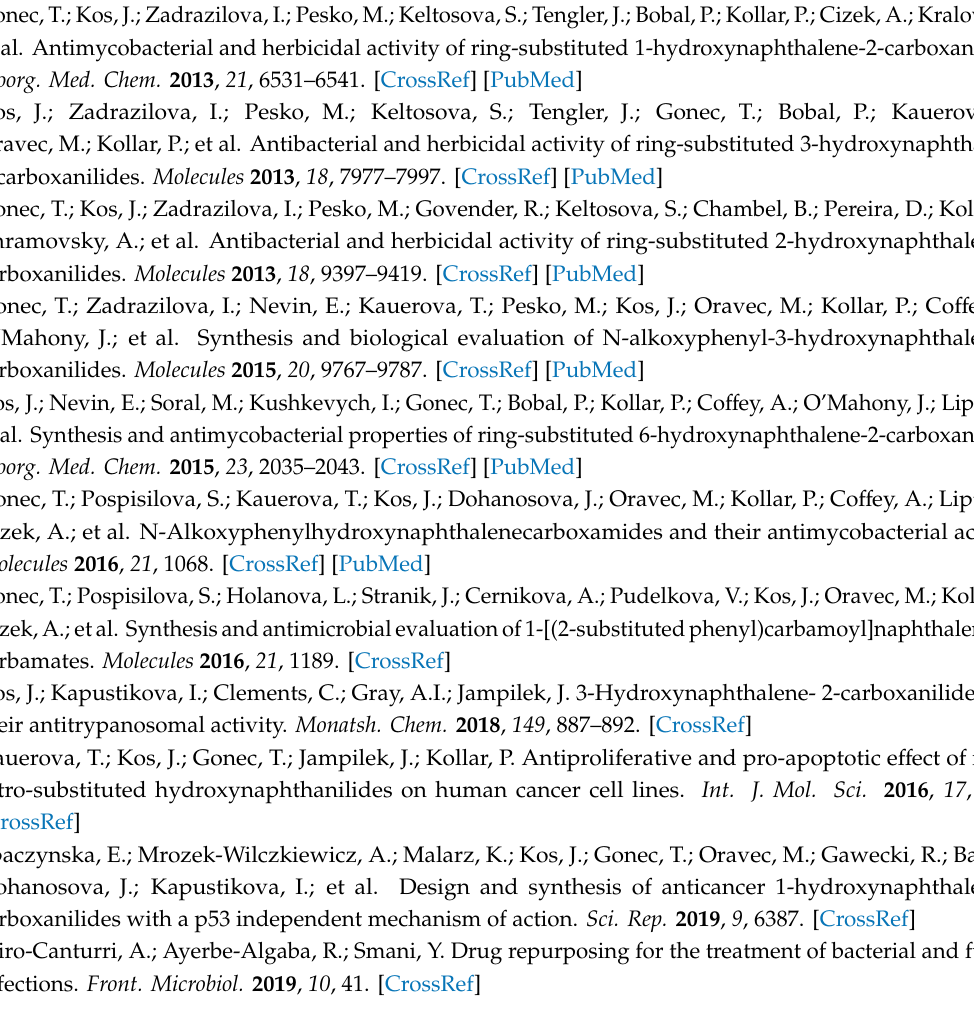
Supplementary Materials: The supplementary material is available online. Figure S1: Part of the crystal structure ofN-(2,5-dimethylphenyl)-1-hydroxynaphthalene-2-carboxamide(11), showingO–H ··· OandC–H ··· Onon-covalent contacts (green dashed lines). Symmetry code: (i) x + 1 / 2,-y + 1 / 2,z-1 / 2; Table S1: Selected bond lengths (Å) and angles ( ◦ ) in 11; Table S2: Parameters (in Å, ◦ ) of selected non-covalent contacts within crystal structure of 11; Table S3: Matrix of correlation coe ffi cients (n = 26, α = 0.05) of linear relationships between particular partition coe ffi cients and experimental lipophilicity data (log k) for N -(methoxy / methyl-phenyl)-1-hydroxynaphthalene-2-carboxamides 1–26; Table S4: Physicochemical properties and calculated HAC, LE and LELP values of 1–26